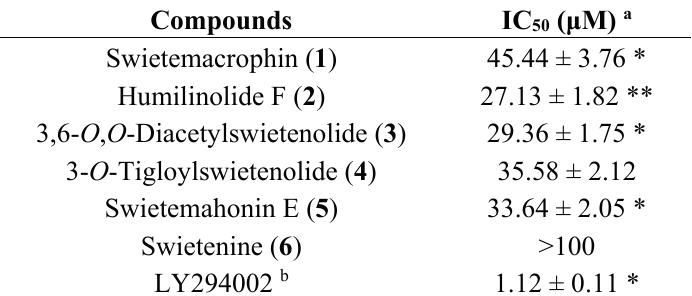
Table 3. Inhibitory effects of compounds 1 – 6 from the seed of S. macrophylla on superoxide radical anion generation by human neutrophils in response to